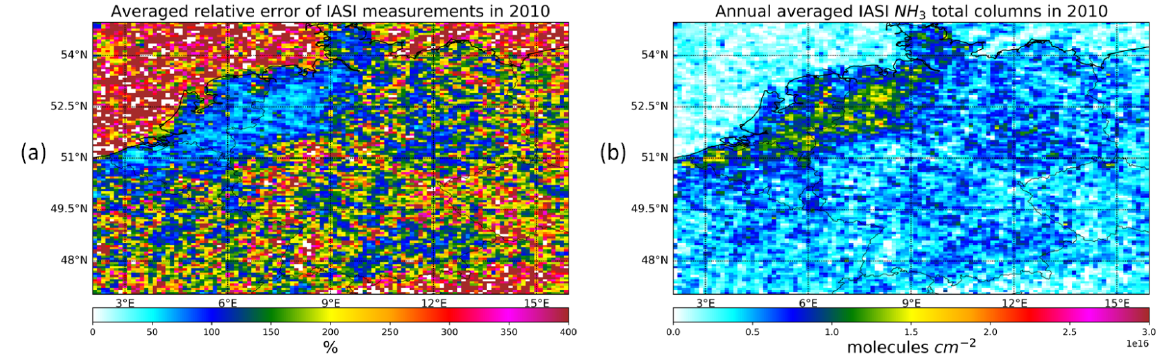
Figure 4. The map of area-averaged relative error of IASI daytime measurements in 2010 (a) . The map of area-averaged total columns after filtering out grid cells with less than 10 valid measurements and an averaged relative error larger than 75% (b) .